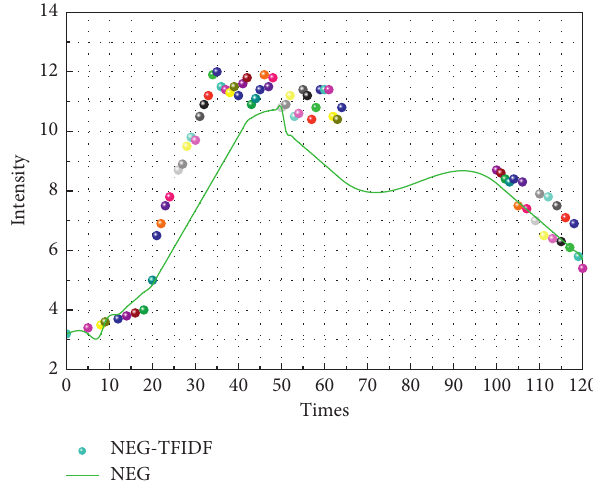
Figure 6: Comparison of the number of the word training.